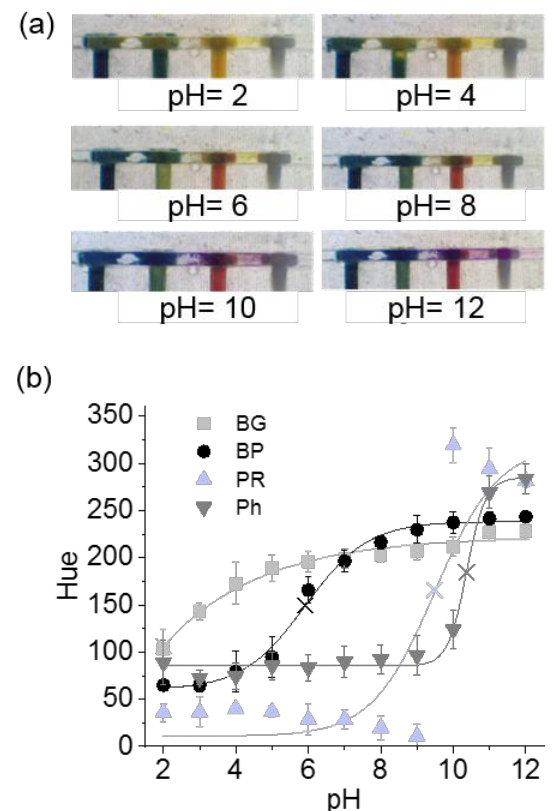
Figure 4. ( a ) Images of the barcode pH sensor are of the microfluidic device for six pH conditions, ranging from 2 to 12. ( b ) Hue ( H ) values for each ionogel pH sensor, when varying the pH from 2 to 12, and the pK a values for each sensor (x). Error bars correspond to the mean values ± SD ( n = 3) for three different devices, which were fabricated at different times, using fresh ionogel solutions each time.